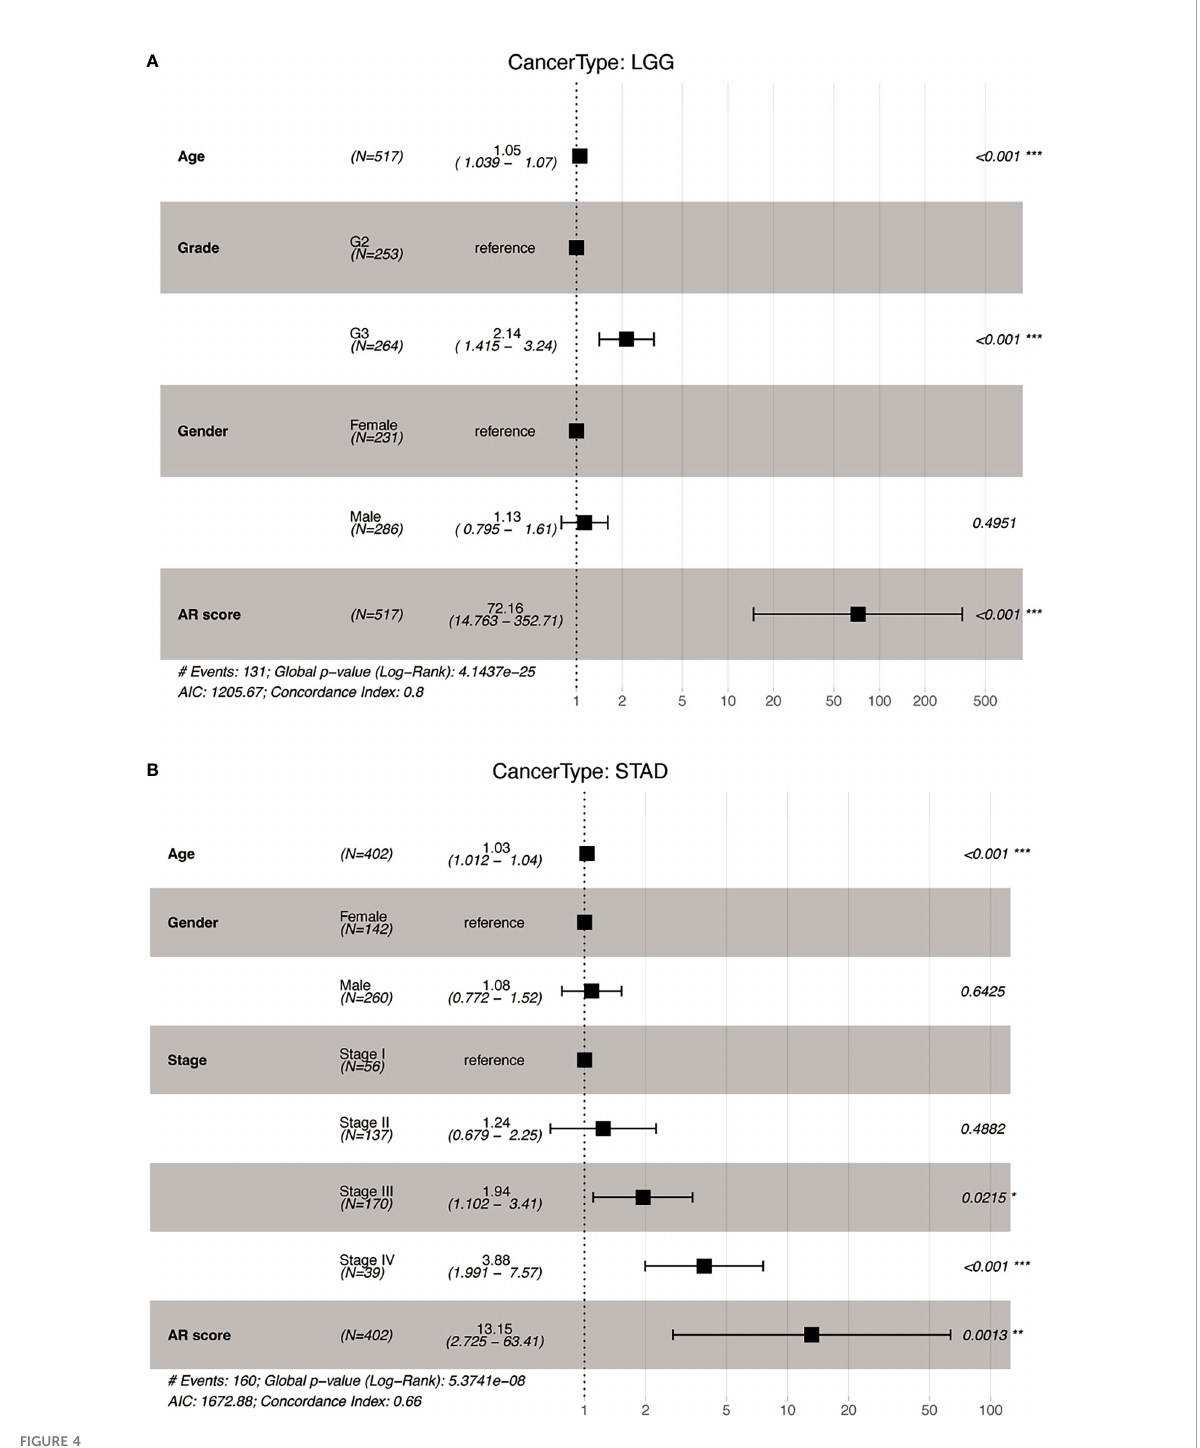
FIGURE 4 The multivariate Cox analyses of the AR score for OS. Forest map of the AR score and clinicopathological parameters for OS in (A) Lower Grade Glioma (LGG) and (B) Stomach adenocarcinoma (STAD). *P < 0.05, **P < 0.01, ***P <